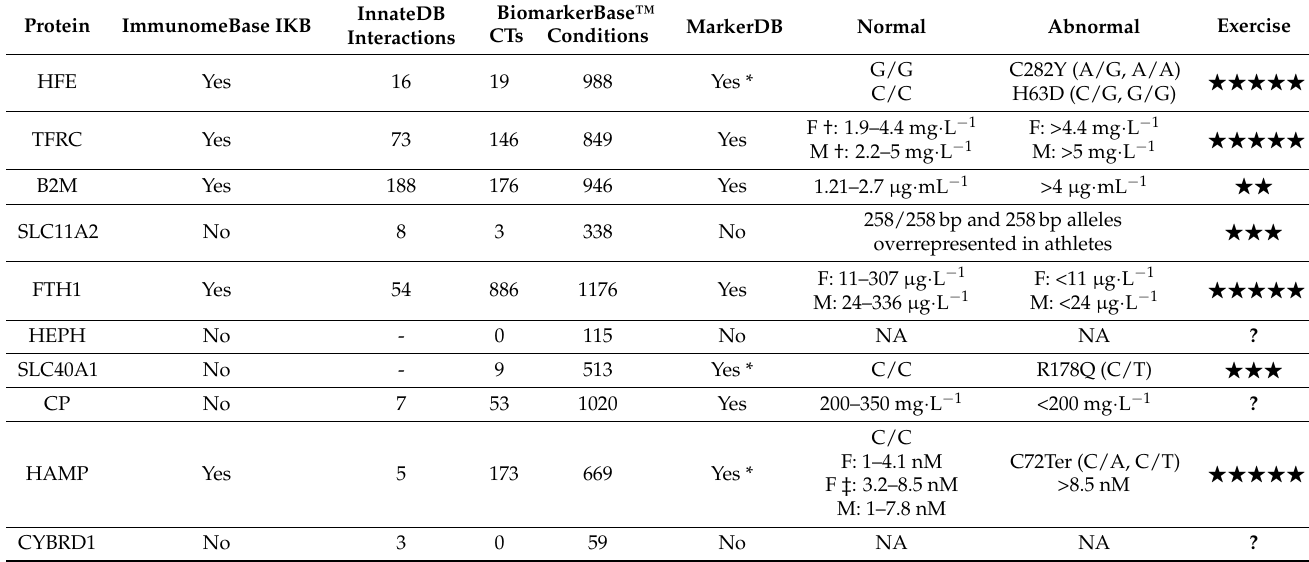
Table 4. Contrasting identified biomarkers to experimentally and manually curated